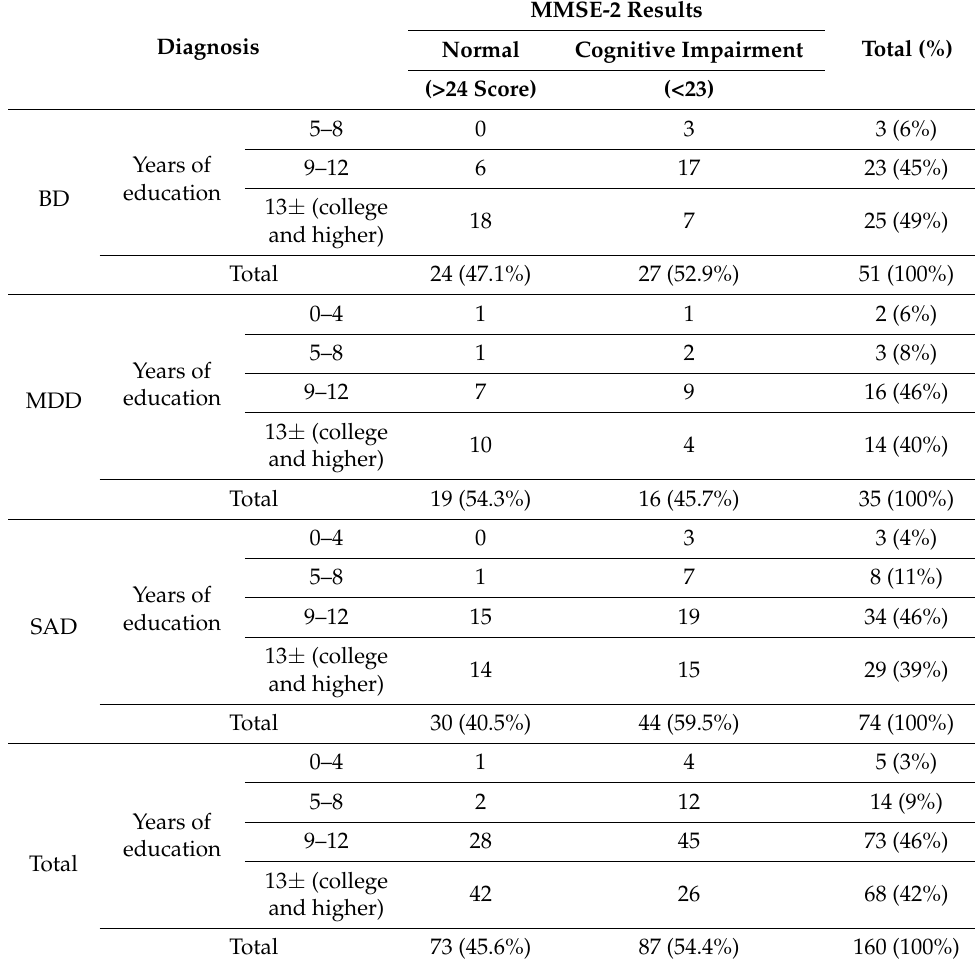
Table 3. MMSE-2 score by the number of years of education and diagnosis.